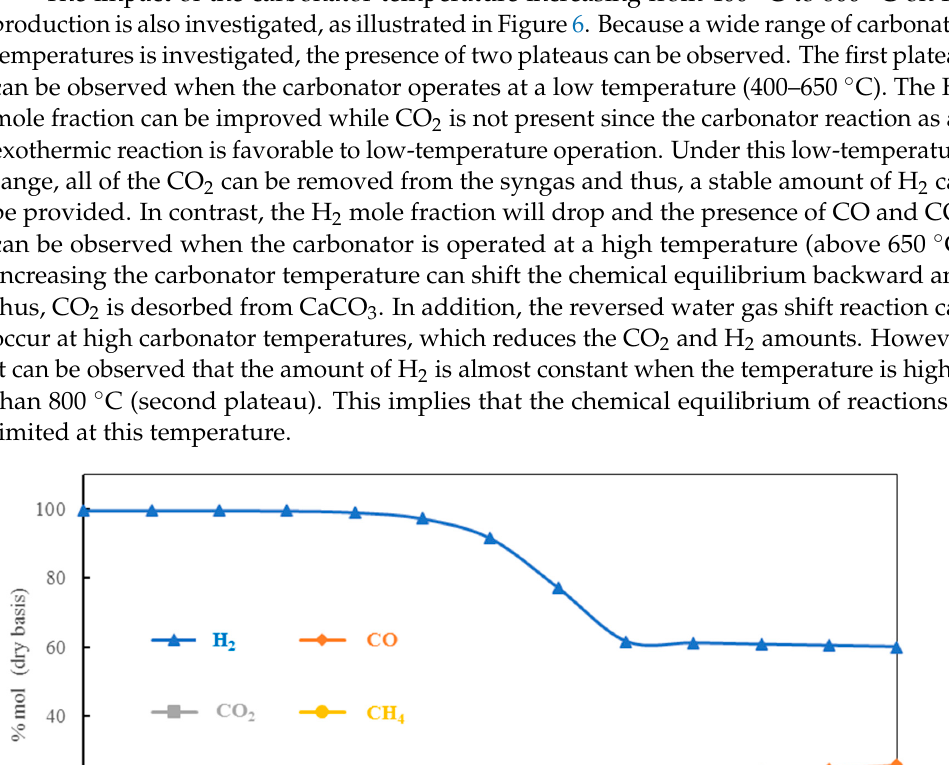
Figure 5. Effect of the CaO/F mass ratio on the gas product composition exited from a carbonator at a gasifier temperature = 700 °C, S/F mass ratio = 1, carbonator temperature = 450 °C, and regenerator temperature = 950 °C.